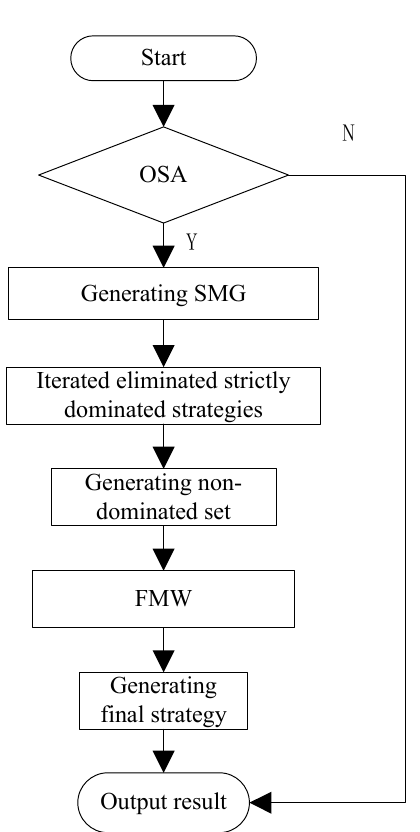
Figure 4. The flowchart of